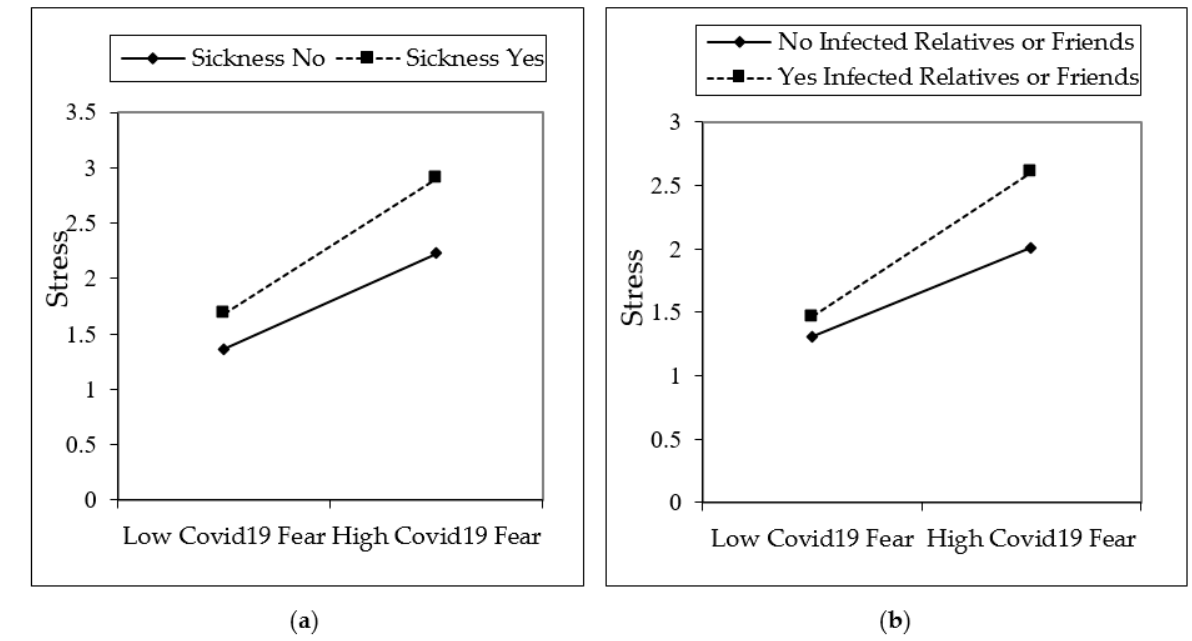
Figure 4. Interaction effects on stress. Moderators of underlying sickness is depicted in a, having infected relatives or friends is depicted in b.